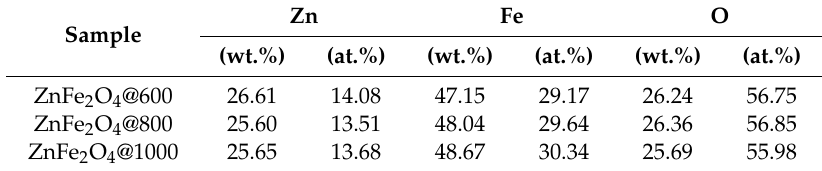
Table 2. The chemical composition of ZnFe 2 O 4 nanoparticles annealed at different temperatures.